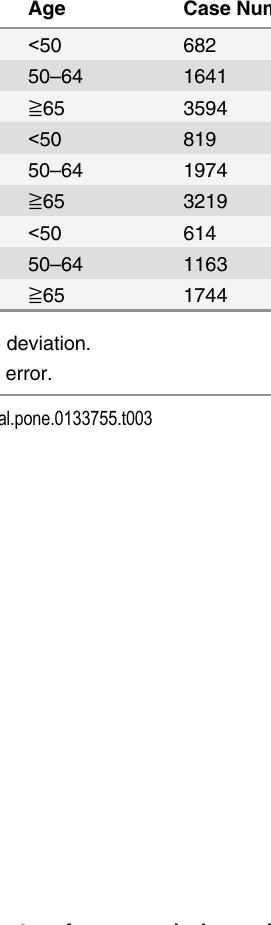
Table 4. Estimates of mean survival years in 10-year of follow-up based on the first 5-year of follow-up data and compared with Kaplan-Meier (K-M) estimates of 10 years of follow-up. Stage Age Cohort